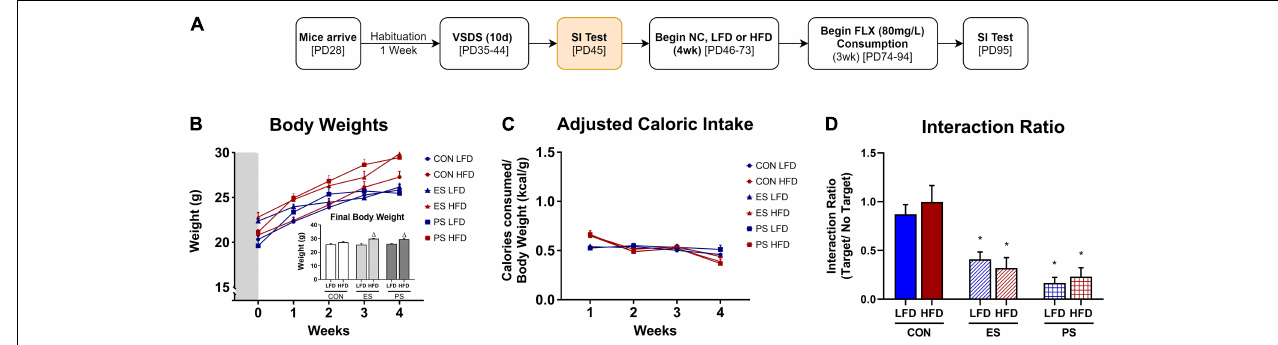
FIGURE 4 | Effects of VSDS exposure prior to 4 weeks of LFD or HFD on social interaction, body weight, and caloric intake. (A) Adolescent mice underwent VSDS ( n = 6/group) and subsequently tested for social interaction. (B) Mice in the ES + and PS + HFD conditions gained weight rapidly and were significantly heavier than the mice in the CON + LFD condition during the final week of diet exposure ( post hoc ; p < 0.05) with an interaction effect between stress, diet and time ( p < 0.05). There was no difference in body weight between the CON + LFD- and the CON + HFD-exposed mice. (C) There were no differences in adjusted caloric intake between the groups in the final week of diet exposure ( post hoc p > 0.05). Novelty induced hyperphagia in the first week results in a main effect of time ( p < 0.05) and diet ( p < 0.05). (D) Mice in the ES + LFD ( p < 0.001) and the ES + HFD conditions ( post hoc p < 0.05) showed an interaction ratio significantly lower than their CON-counterpart. The PS + LFD- and the PS + HFD-exposed mice also showed a significant reduction in social interaction compared to their respective CON-counterpart mice ( post hoc p < 0.05, respectively). There was no difference between the interaction ratio of LFD and HFD exposed mice in either ES or PS groups. All data are expressed as the mean ± SEM. (cid:49) p < 0.05: significantly different than their respective LFD-exposed